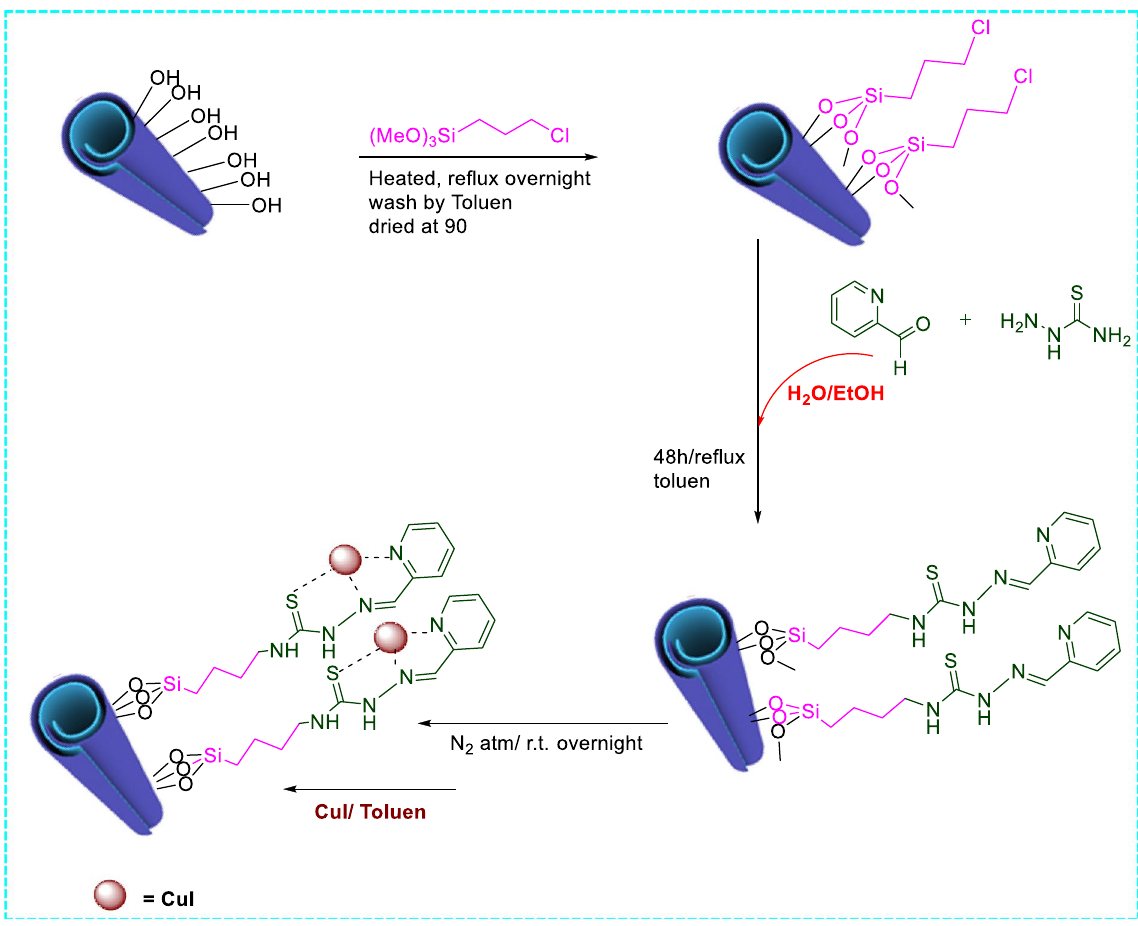
Figure 1. Preparation of